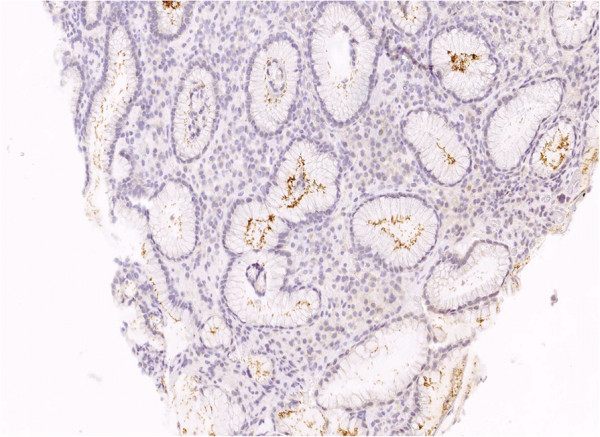
Immunohistological evidence of H. pylori. H. pylori was discovered in 2 of the 20 mucosa samples. The specimen from Figure 5 has been subjected to immunohistochemistry treatment by anti-Helicobacter-antibody, staining H. pylori brown.